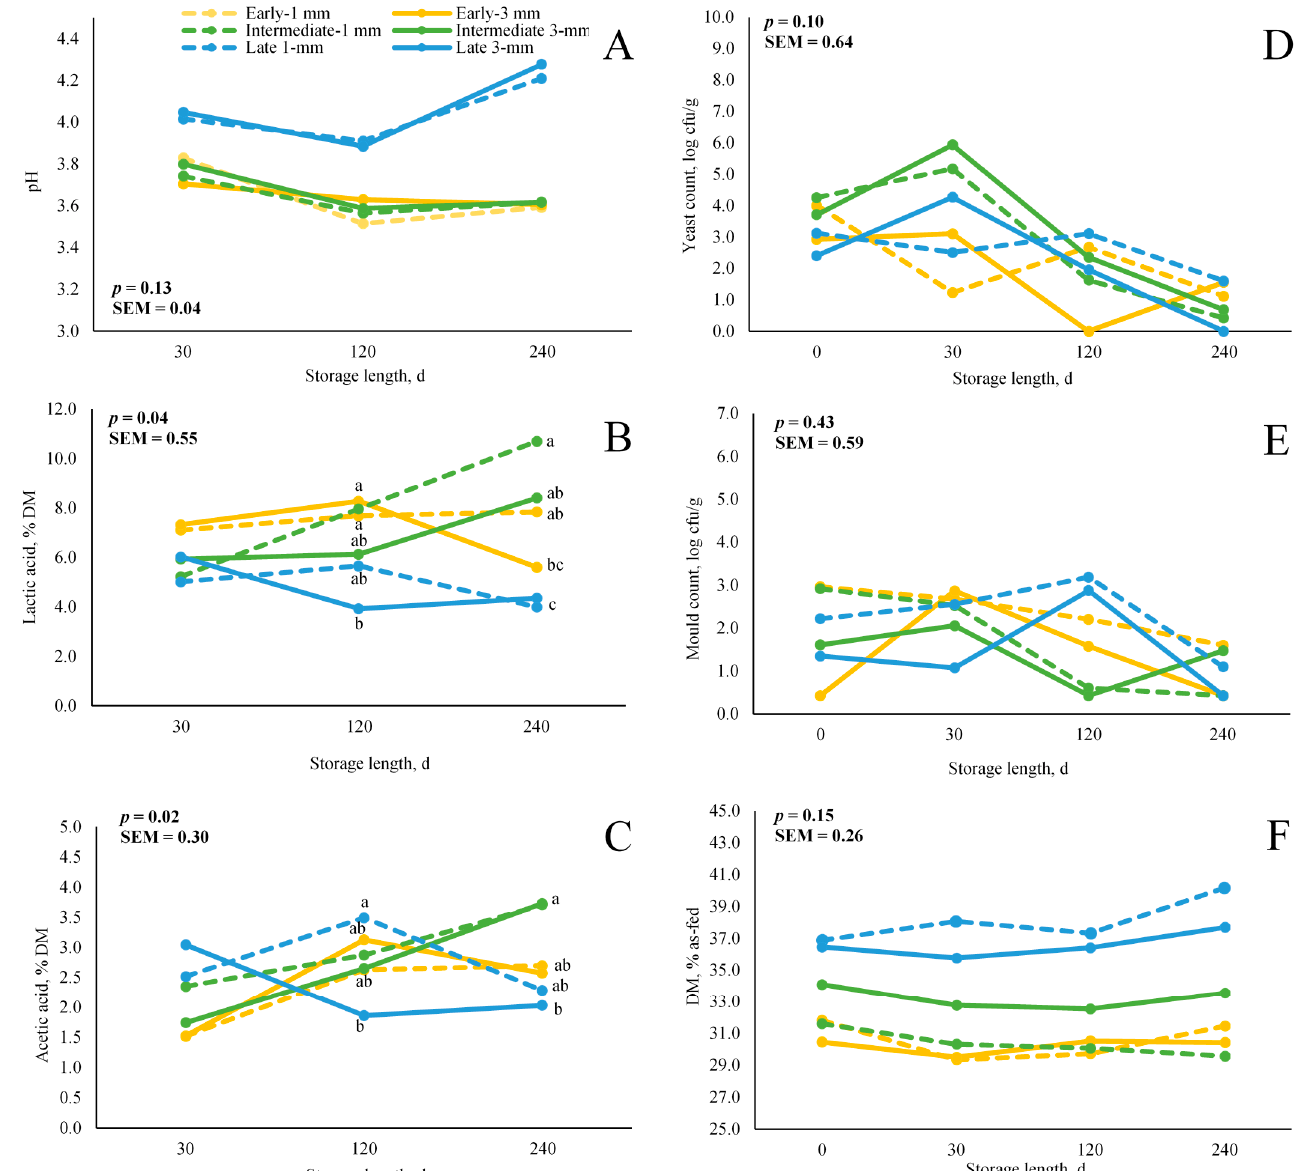
Figure 1. The effect of maturity, roll gap width, and storage length on pH ( A ), lactic ( B ) and acetic acid ( C ) concentrations, yeast counts ( D ), mould counts ( E ), and concentrations of DM ( F ) in whole-plant maize silage ( n = 96). Means within the same day with different letters (a,b,c) differed ( p ≤ 0.05). Whole-plant maize was harvested at 3 maturities (1/4 (Early), 1/2 (Intermediate), and 3/4 (Late) kernel milk line) and processed through rolls with a gap width of either 1 or 3 mm using a self-propelled forage harvester. Silage was stored for 0, 30, 120, or 240 d.